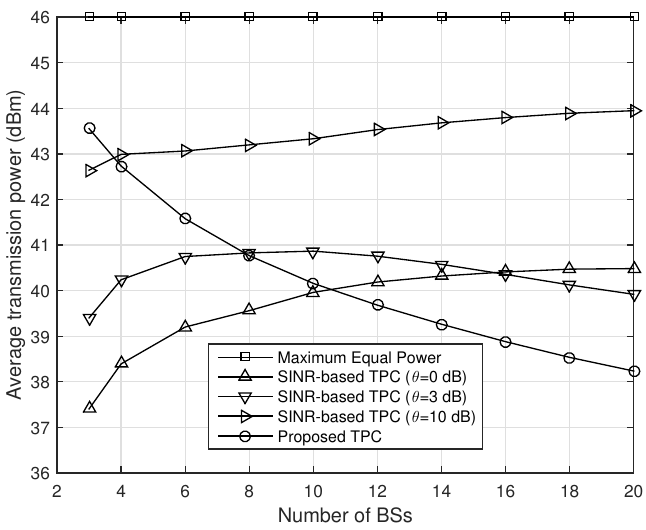
Figure 7. Average transmission power vs. number of BSs.